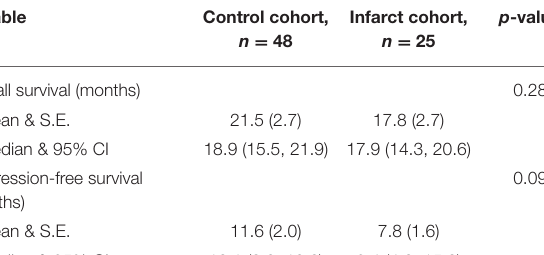
TABLE 3 | Survival outcomes.